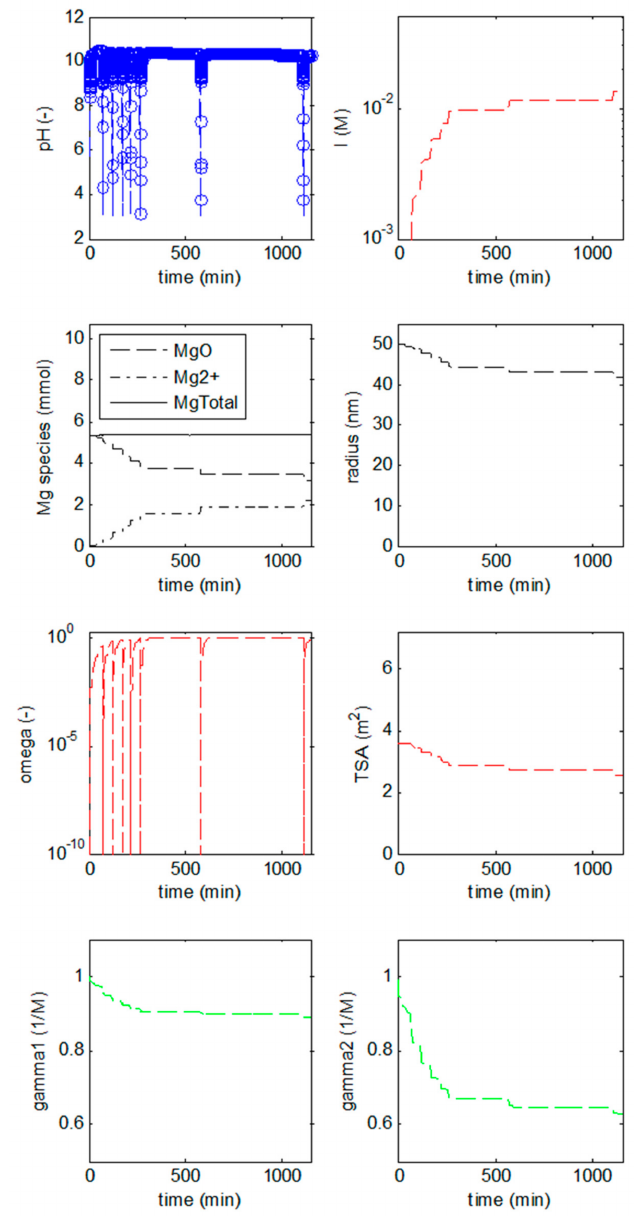
Figure 5. Time-variable properties of the mineral dissolution model: pH response as shown in Figure 4, ionic strength (I), Mg speciation, average particle radius, omega term, total particle surface area (TSA) and activity coefficients of mono- (gamma1) and divalent (gamma2) ions. Table 3. Fitted values of the lumped mass transfer coefficient (k L ) and solubility product (K sp,MgO ) for the linear driving force model used to describe the alkalinity release kinetics from MgO particle- containing oil-in-water